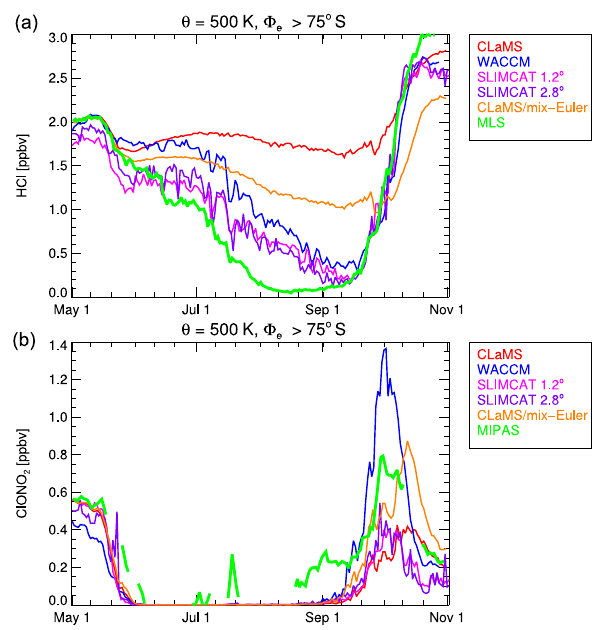
Figure 6. Vortex-core averages ( (cid:56) e > 75 ◦ S) on the 500K isentrope for HCl (a) and ClONO 2 (b) for different model simulations. Obser- vations of MLS and MIPAS are shown as green lines. The red line corresponds to CLaMS, the blue line corresponds to SD-WACCM, and pink and purple lines correspond to TOMCAT/SLIMCAT sim- ulations with horizontal resolution 1.2 and 2.8 ◦ , respectively. The orange line corresponds to the CLaMS “mix-Euler” simulation, in which additional artificial mixing was applied.